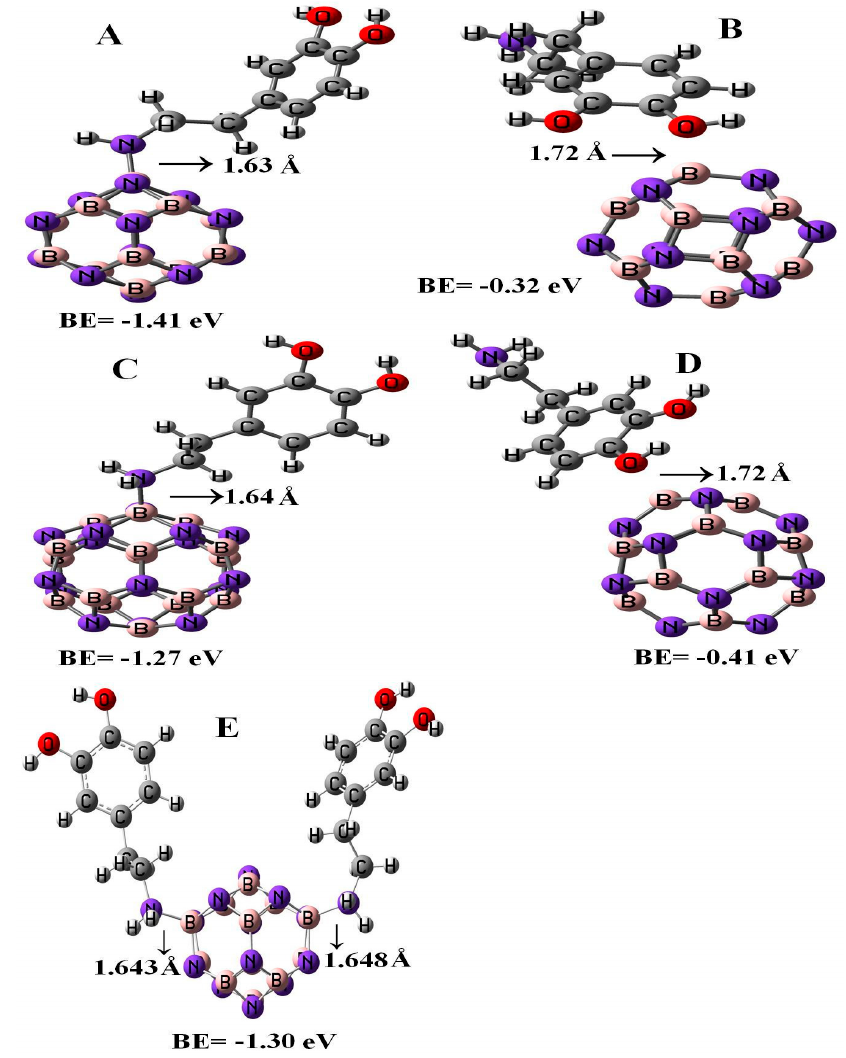
Figure 2. Single and double DPM adsorbed over the B 12 N 12 and B 16 N 16 nano-cages.